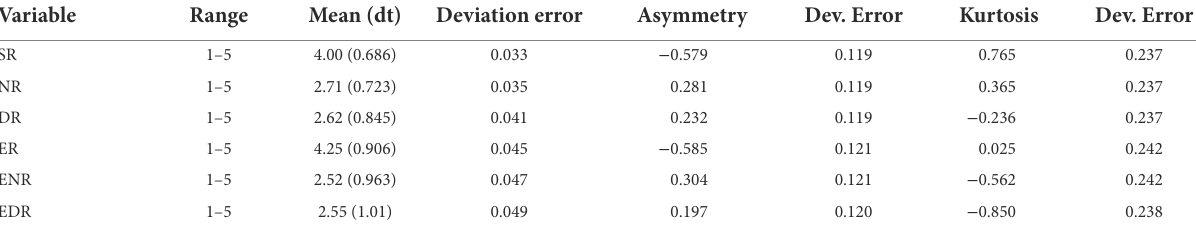
TABLE 9 Values descriptive of the validation sample ( n =